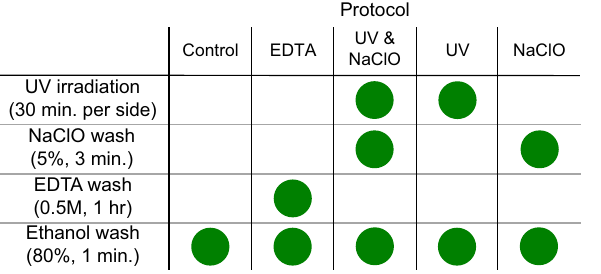
Figure 1. The five decontamination protocols applied. A workflow, from top to bottom, for each of the decontamination protocols applied to the groups of ancient dental calculus samples. Green dots represent use of that treatment on each sample being